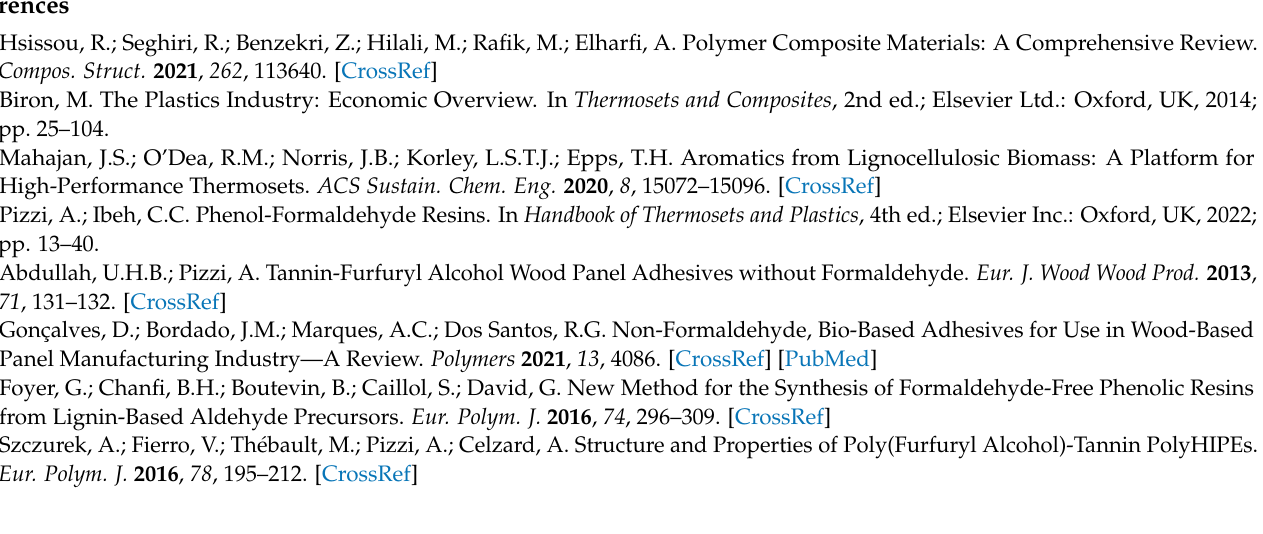
(blue) and PFA ◦ (red) of the CH 3 area. The blue spectrum is stacked on top of the red one. Figure S2: HMBC spectra of PFA ◦ (red) and PFA+ (blue) focusing on the methyls. The red spectrum is on top of the blue one. Figure S3: Magnified HSQC spectra of PFA+ (blue) and PFA ◦ (red) of the CH 2 area. The blue spectrum is stacked on top of the red one.Figure S4: Magnified HSQC spectra of PFA+ (blue) and PFA ◦ (red) of the dienes and ethers areas. The blue spectrum is stacked on top of the red one. Figure S5: Magnified HSQC spectra of PFA+ (blue) and PFA ◦ (red) of the aldehyde area. The blue spectrum is stacked on top of the red one. Table S1: Data obtained from the C=O quantification, enthalpies from DSC and the calculated conversion degrees. Table S2: 1 H and 13 C NMR predicted chemical shift of a furfuryl lactone unit. Table S3: MALDI ToF